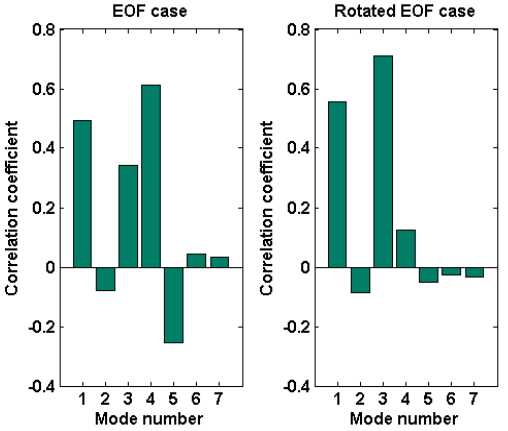
Fig. 4. Correlation of the first seven EOF loadings with the time of Fig. 4: Correlation of the first seven EOF loadings with the time of observation for the observation for the unrotated (left panel) and rotated (right panel) unrotated (left panel) and rotated (right panel) EOF cases. EOF cases.